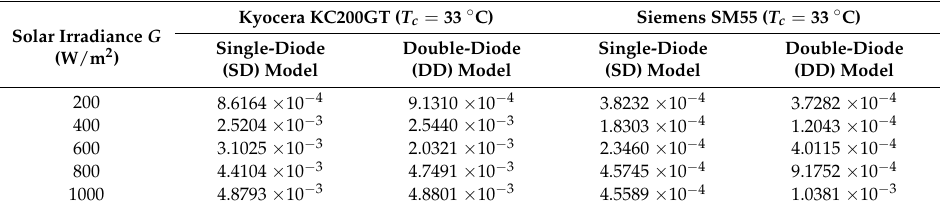
Table 4. RMSE values between the measured and estimated I-V characteristics at different solar irradiance levels (200, 400, 600, 800 and 1000 W/m 2 ) and fixed cell temperature ( T c = 33 ◦ C ), extracted from an individual PV cell from both the Kyocera KC200GT and Siemens SM55 Solar Panels.